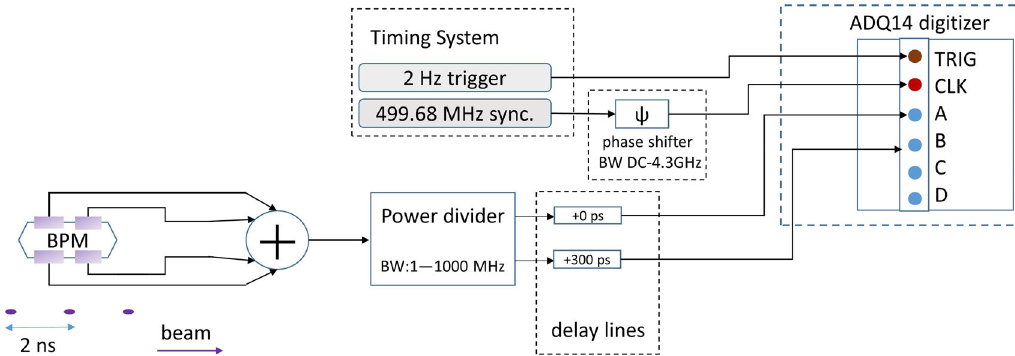
FIG. 1. The system framework of the bunch-by-bunch monitor. The BPM sum signal from four electrodes was split into two parts with 300 ps delay lines by a power divider (BW 1 MHz1000 MHz). Two sampling points on the rising edge of the BPM signal were captured by a high-speed ADQ digitizer (14 bits, 1 GHz sampling rate, 1:2 GHz bandwidth). The ADC external clock signal of 499.654 MHz, directly come from the timing system of the machine, aiming at the synchrotron sampling of signals. The clock was followed by a tunable shifter with maximum phase excursion of 2 ns to ensure the capture of zero-crossing point of the rising edge of the signal. The system can achieve 3 million points (2083 turns) of data, which is enough for us to obtain the whole oscillation